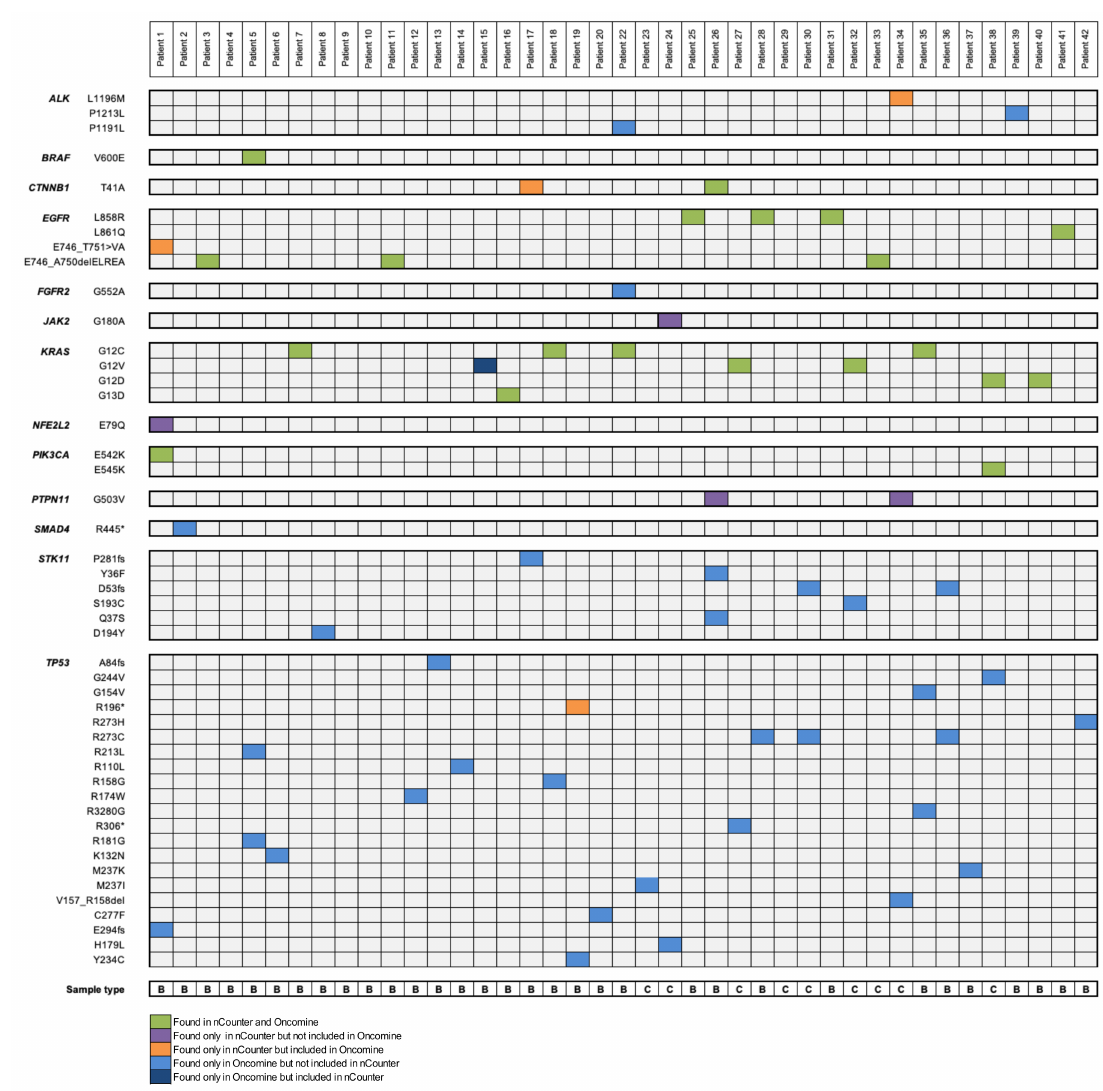
Figure 5. Mutation plot of single nucleotide variants identified in the 41 patients tested by both the nCounter Vantage 3D Solid Tumour Assay and the Oncomine Solid Tumour Panel DNA Kit. Alterations are colored depending in which panel they were detected. Four patients were negative for all the mutations tested. B: Biopsy; C: